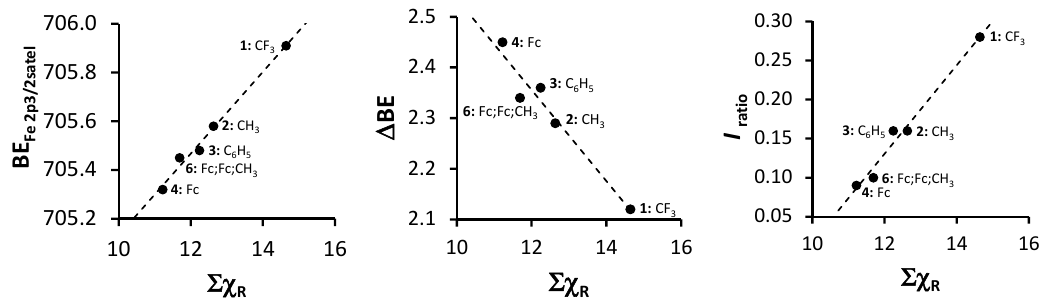
Figure 8. Left : Relationship of binding energy of the satellite Fe 2p 3/2 phototelectron line of 1 – 4 and 6 (BE Fe2p3/2satel ) and the sum of β -diketonato ligand Gordy scale R-group electronegativities, Σχ R . Middle : Relationship between Δ BE = BE Fe2p3/2main − BE Fe2p3/2satel and Σχ R . Right : Relationship between I ratio = ( I Fe2p3/2satel )/( I Fe2p3/2main ) and Σχ R .